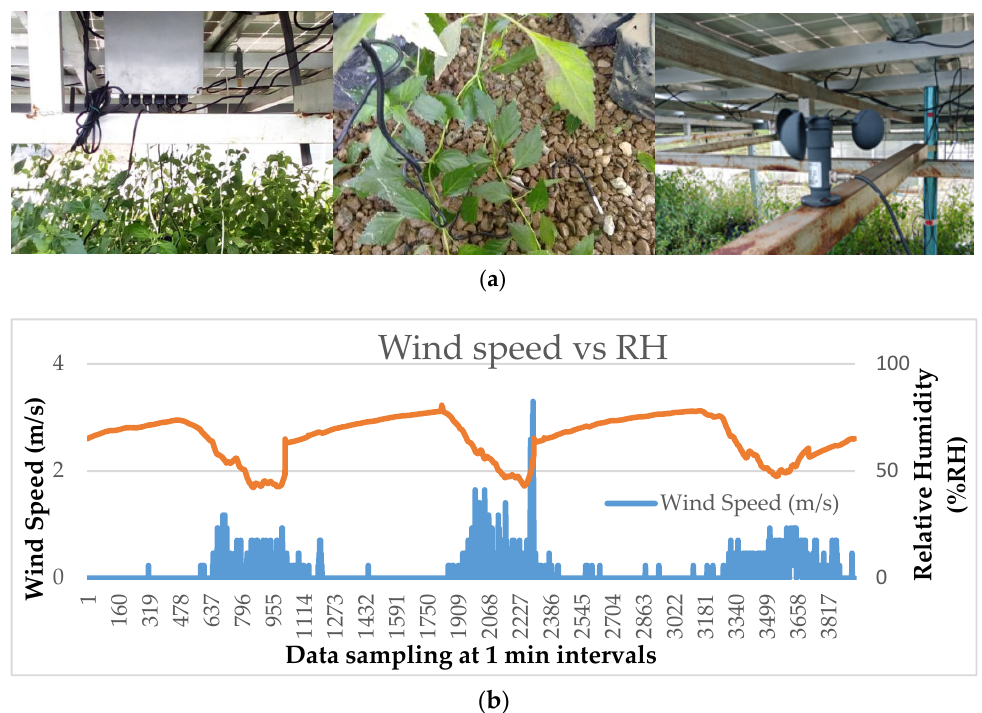
Figure 4. ( a ) Installation of the data acquisition (DAQ) compartment, thermo sensor and other environmental sensors; ( b ) Data plots for relative humidity (RH) and wind speed for agrivoltaic plots.